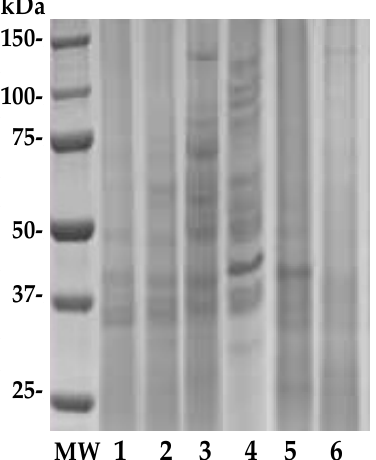
Figure 1. Representative 1-DE gel image. MW, molecular weight marker (All Blue Precision Plus Protein Standard, Bio-Rad) expressed in a kilodalton (kDa). Lane 1, C group-B; lane 2, C group-T; lane 3, CHX group-B; lane 4, CHX group-T; lane 5, CHX+ADS group-B; lane 6, CHX+ADS group-T. Separation was performed on precast gel Bolt 12% Bis-Tris Plus and protein bands were stained with 0.2% silver nitrate.